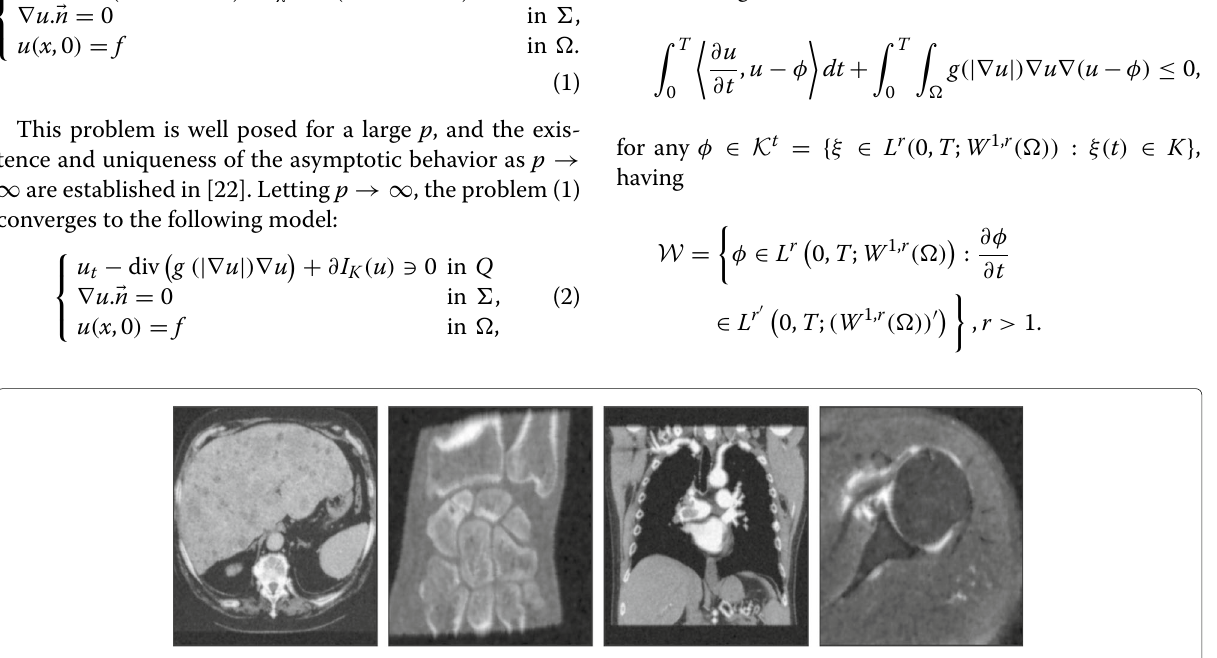
Fig. 3 Restored images by using our